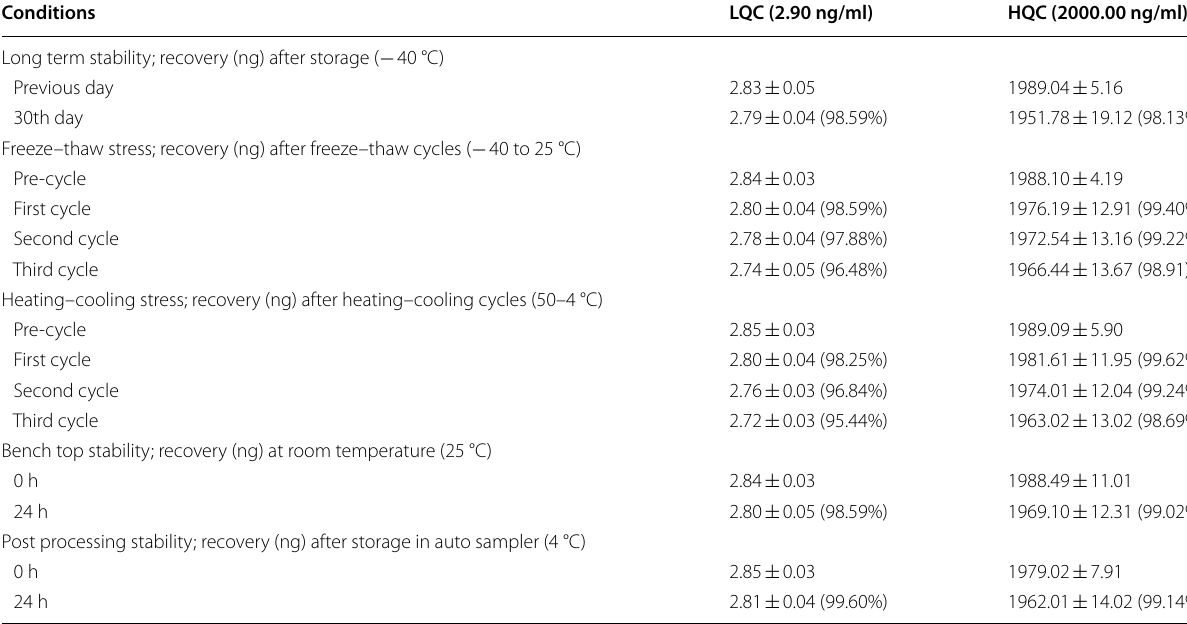
Values (Mean SD) are derived from six replicates. Figures in parenthesis represent analyte concentration (%) relative to time zero. Theoretical contents; LOQQC: ± 1.01 ng/ml, LQC: 2.9 ng/ml; MQC: 1000 ng/ml; and HQC: 2000 ng/ml